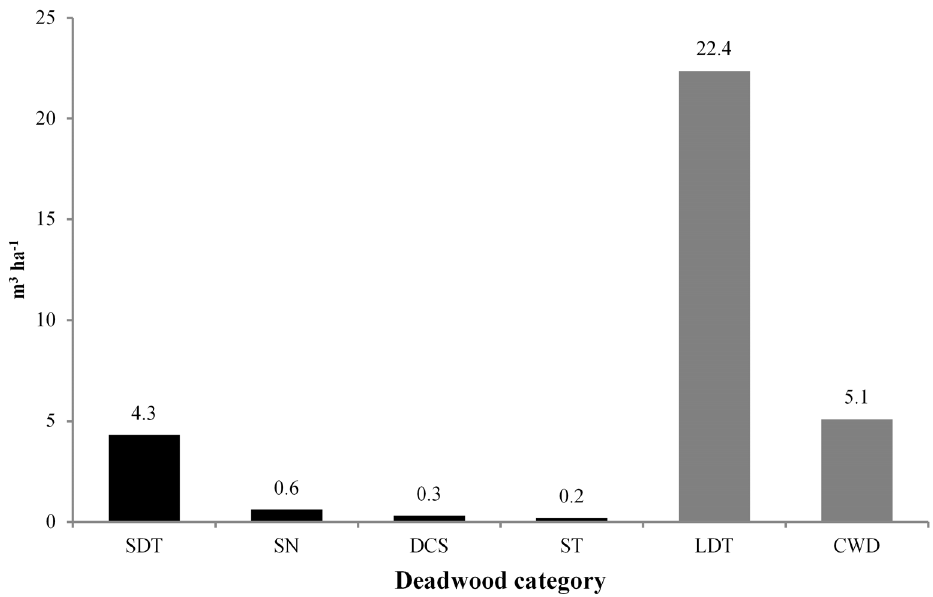
Figure 7. Relative contribution of each deadwood category to total deadwood volume (m 3 ha − 1 ). Table 4. Total number and volume of deadwood categories of coarse deadwood (DBH ≥ 30 cm from Lombardi et al. [38]).